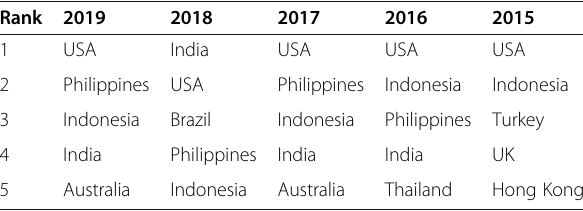
Table 3 Top five countries or regions that accessed